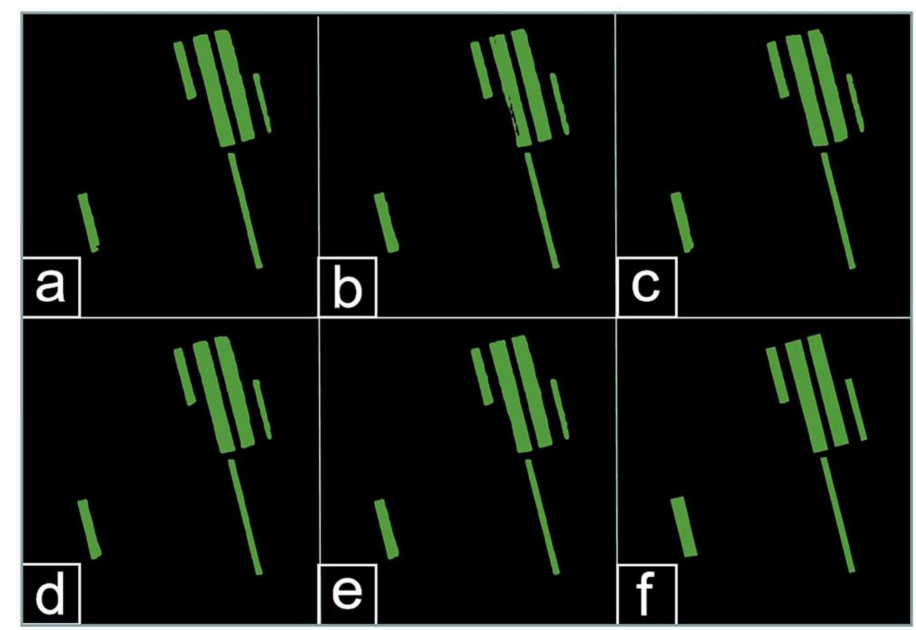
Figure 9. Greenhouse segmentation results of deeplabV3+ models with different backbone networks